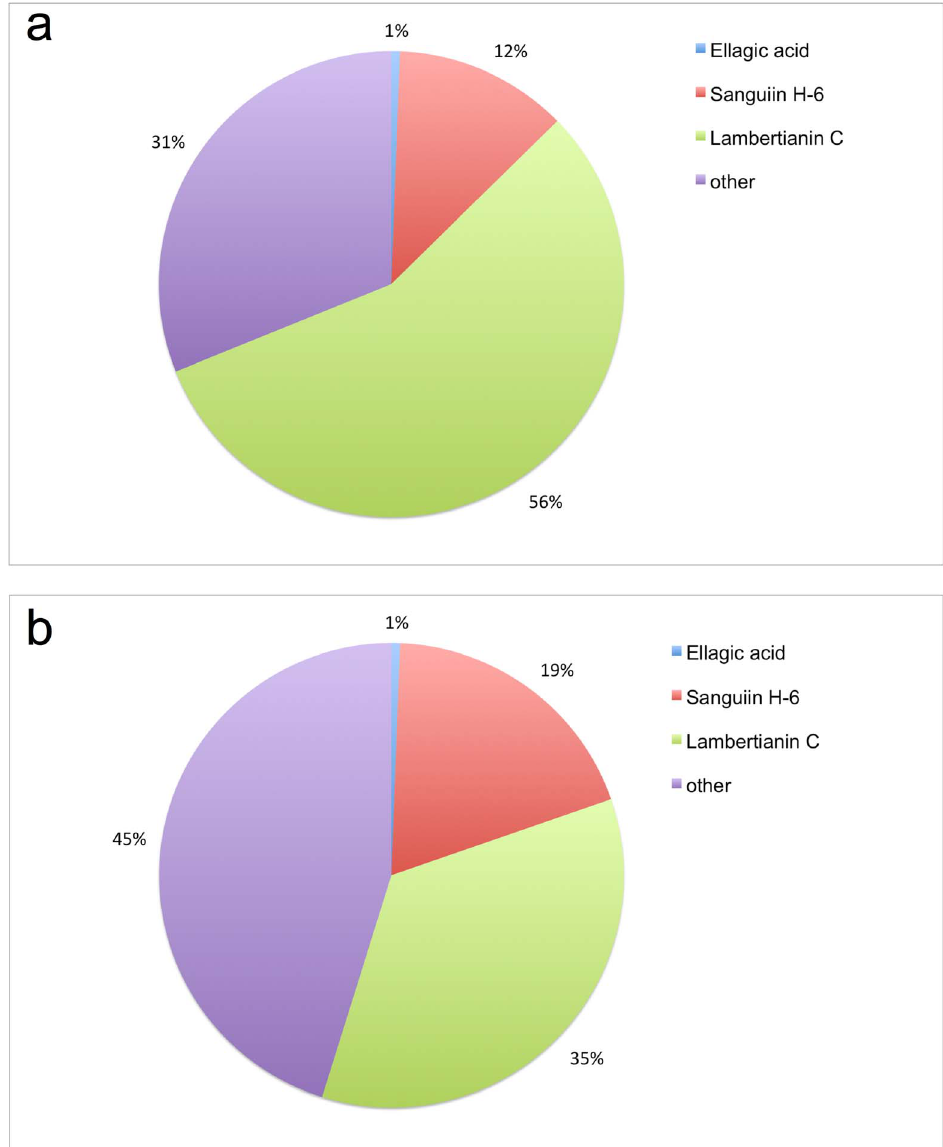
Figure 2. Composition of blackberry (ETblack) and raspberry (ETrasp) ellagitannins. Berries ETs were extracted with acetone/water 70:30, isolated by Sephadex LH 20 column chromatography, precipitated with hexane and quantified by UPLC-PDA-MS. Ellagitannins were detected at 260 nm.